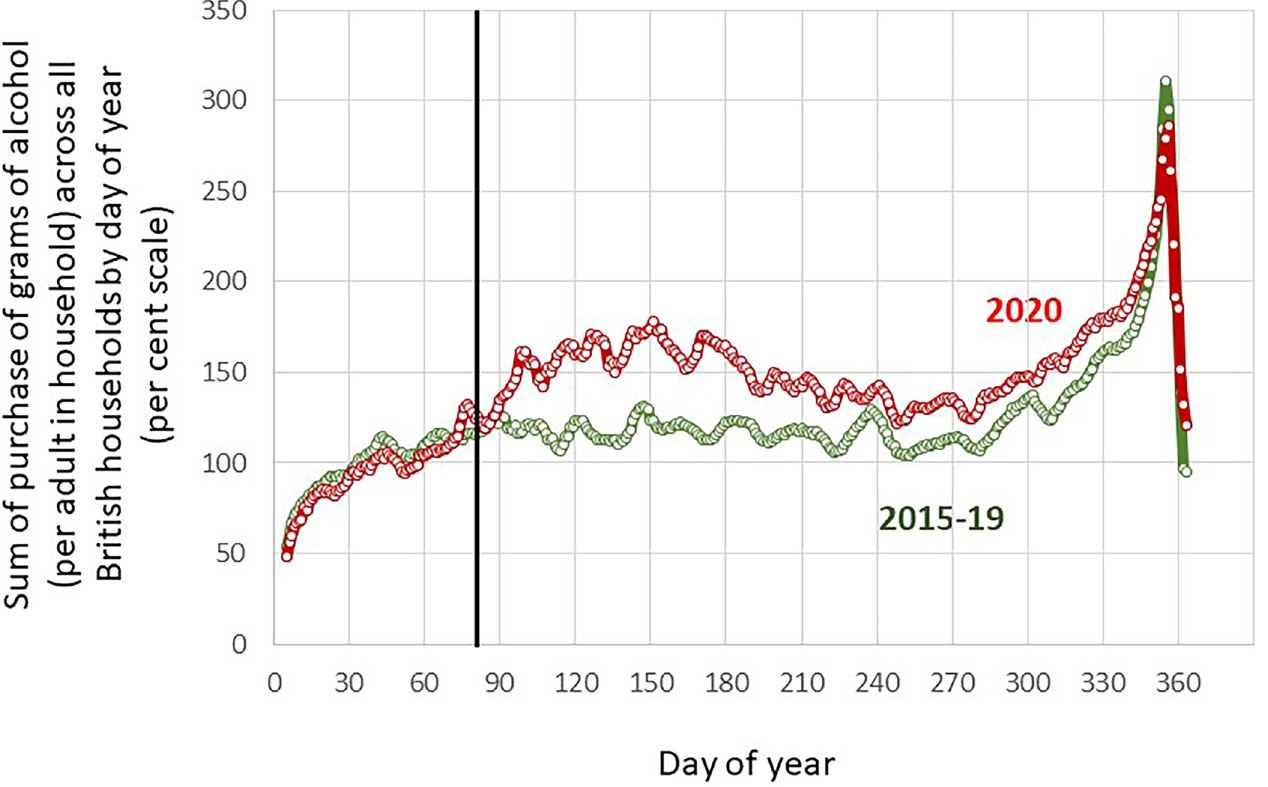
Fig 1. Plots of purchases of grams of alcohol by day of year for 2015–2019 (averaged) and 2020. Purchases are the sum of purchases in grams of alcohol per adult per household per day across all households for each day of the year, converted to a per cent scale, where 100% is the mean of the sum of purchases per day for the average of the days of 2015–2019 up to 22 nd March, covering the days of the year before